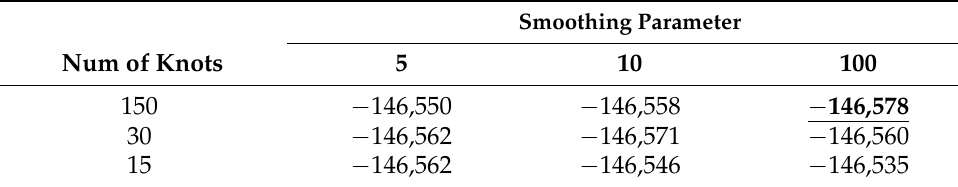
Table 2. DIC for Weibull distribution (4 January 2016, TMC, Aichi, Japan).